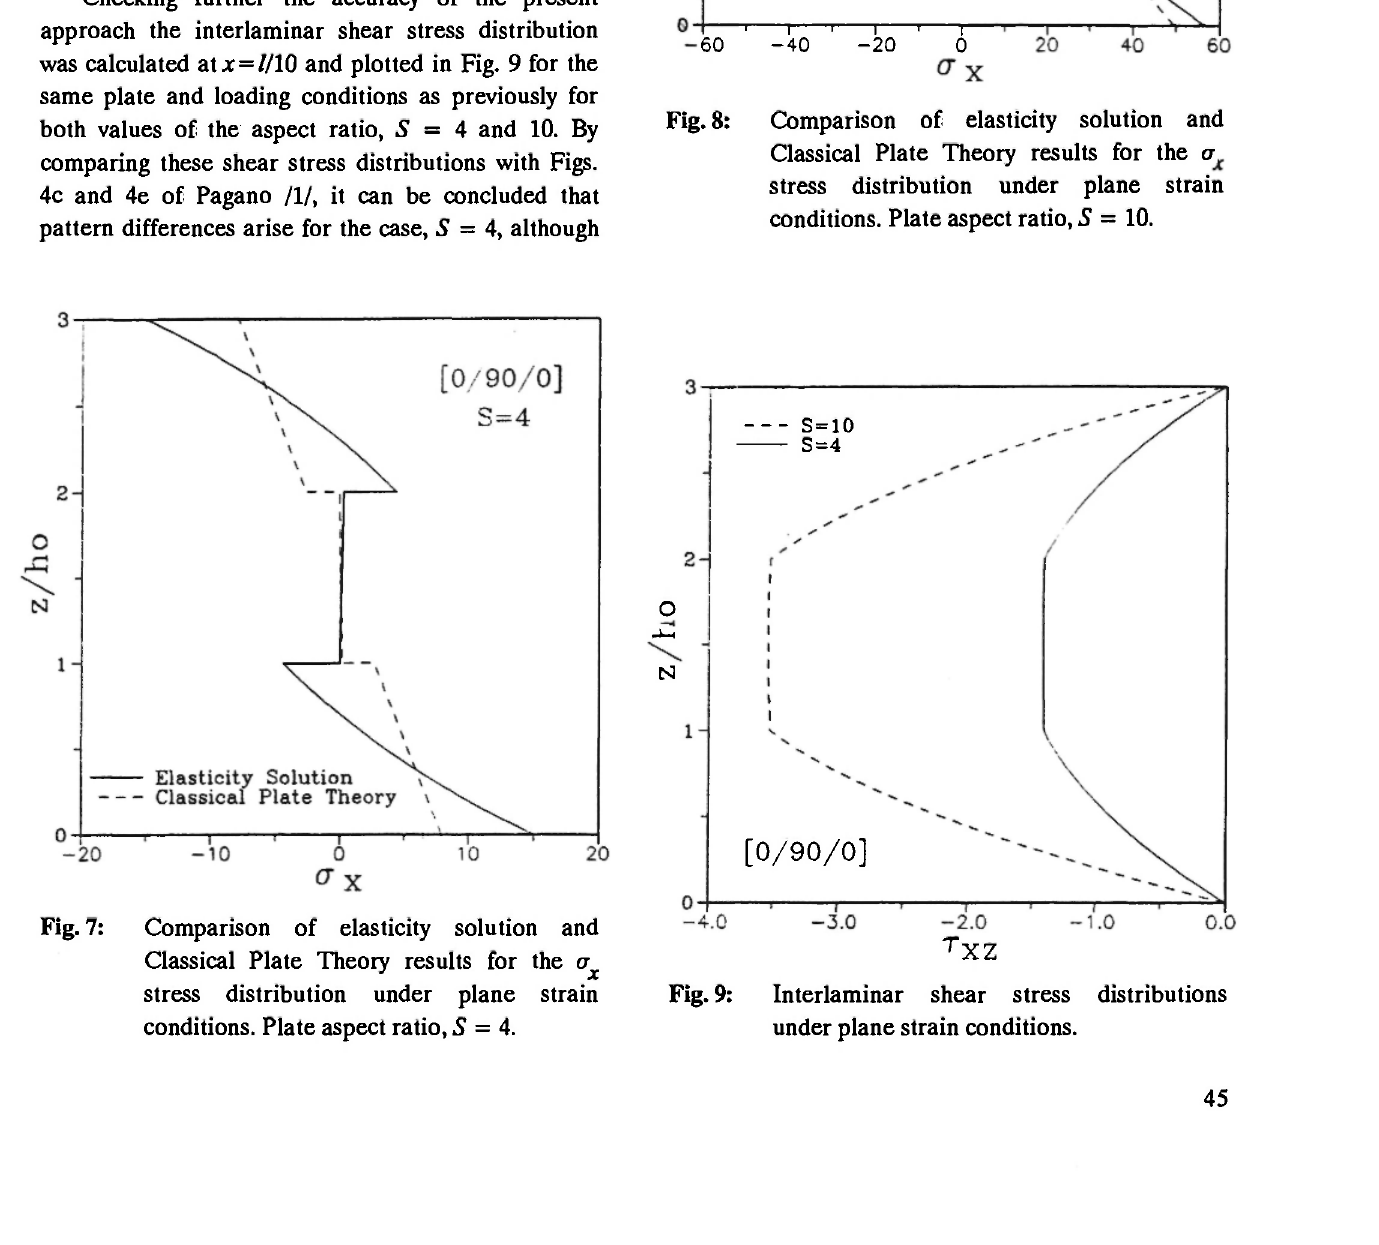
Fig. 8: Comparison of elasticity solution and Classical Plate Theory results for the a stress distribution under plane strain conditions. Plate aspect ratio, S = 10.